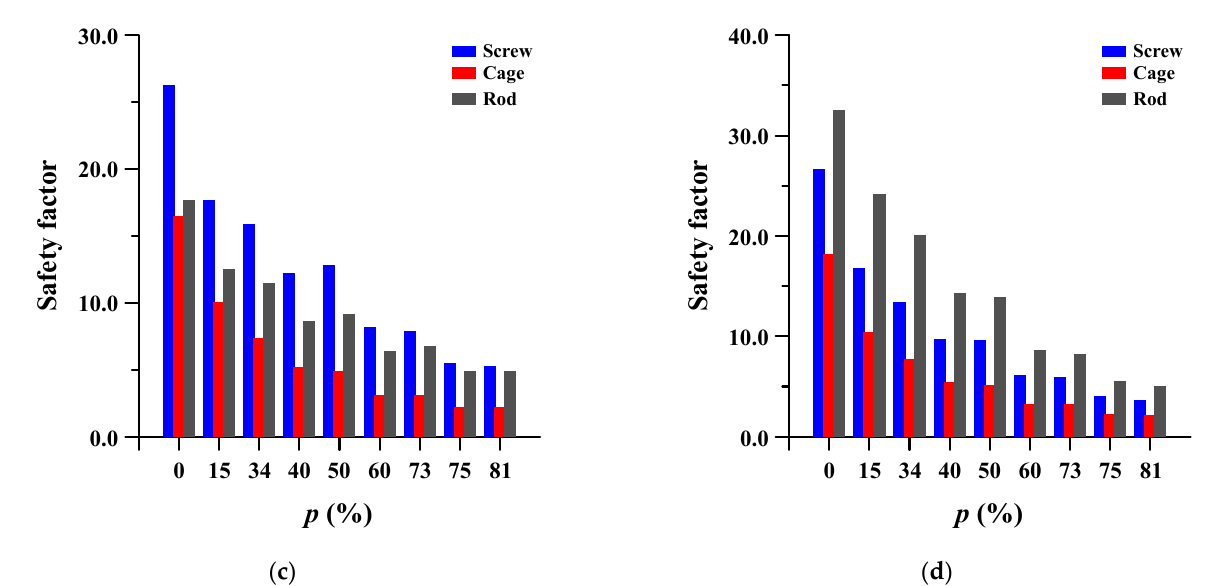
Figure 12. Safety factor (equivalent stress/yield stress) of pedicle screw, spinal cage and spinal rod at different porosities ( p ) of spinal implants in each spinal motion: ( a ) flexion; ( b ) extension; ( c ) lateral bending; and ( d ) rotation.